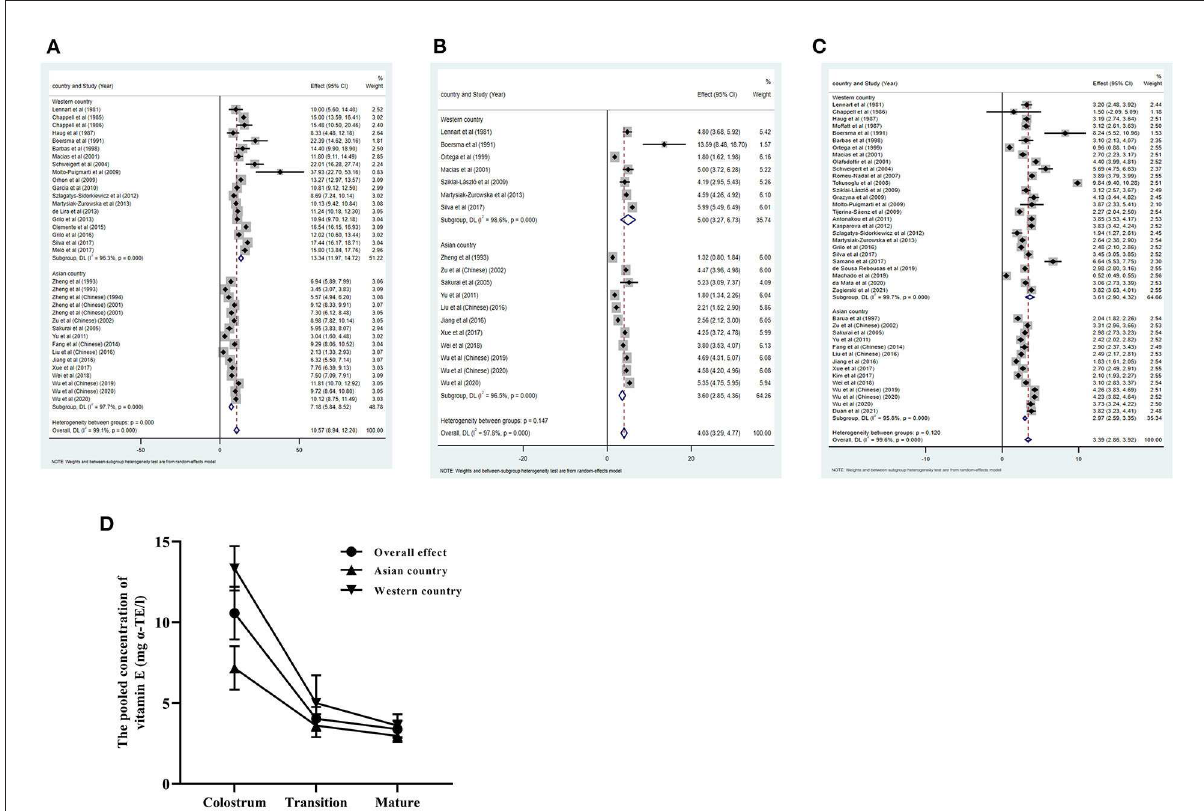
FIGURE3 Sub-group analysis showed the pooled concentration of vitamin E based on Western countries and Asian countries in colostrum (A) , transitional milk (B) and mature milk (C) . The trend of pooled results in different periods of lactation (D) .